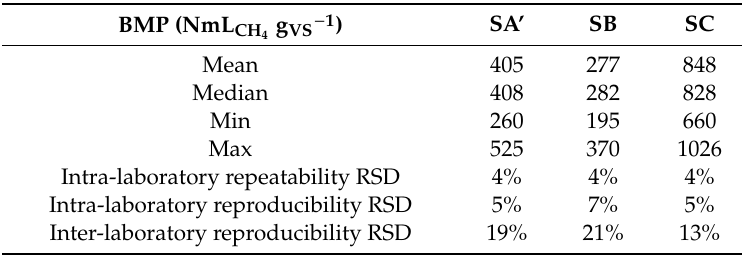
Table 7. Synthesis for the second phase of the French inter-laboratory